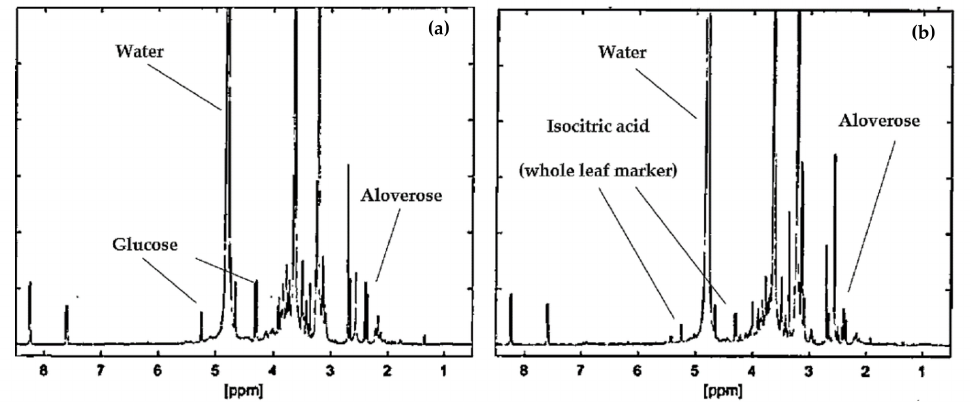
Figure 1. Quantitative proton nuclear magnetic resonance spectroscopy ( 1 H-NMR) spectra for Aloe